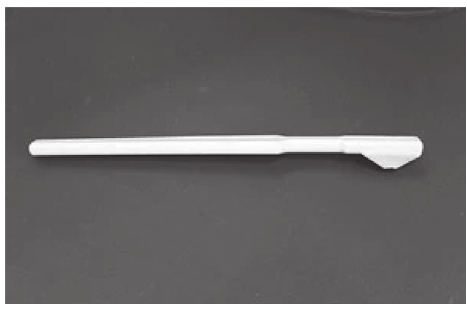
Figure 3: Tooth Slooth tool for the bite test